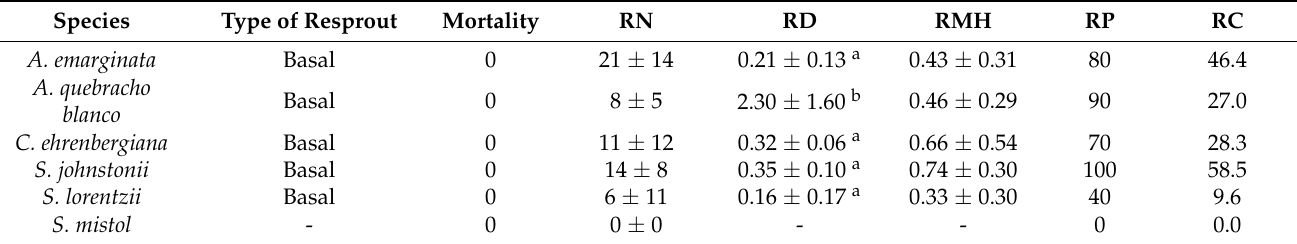
Table 3. Mean and standard deviation for the post-fire resprout number (RN), resprout diameter (RD, cm), and resprout maximum height (RMH, m). Additionally, this table showed the type of resprout, the post-fire mortality (%), the resprouting percentage (percentage of plant population that have resprouted, RP), and the resprouting capacity (RC) of each species. Resprouting measurements were made with data from EB 2016. Different letters indicate significant differences, according to LSD Fisher pairwise comparison procedure with α :